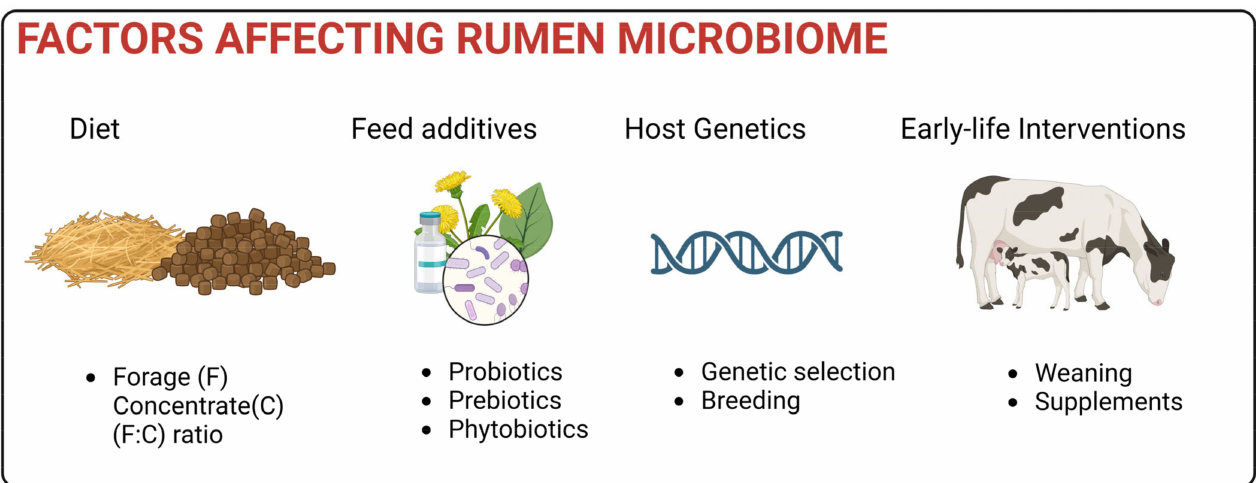
Figure 4. Factors affecting the rumen microbiome: Diet is the major factor affecting rumen microbiome. Other factors include supplementation of feed additives, host genetics, and early life